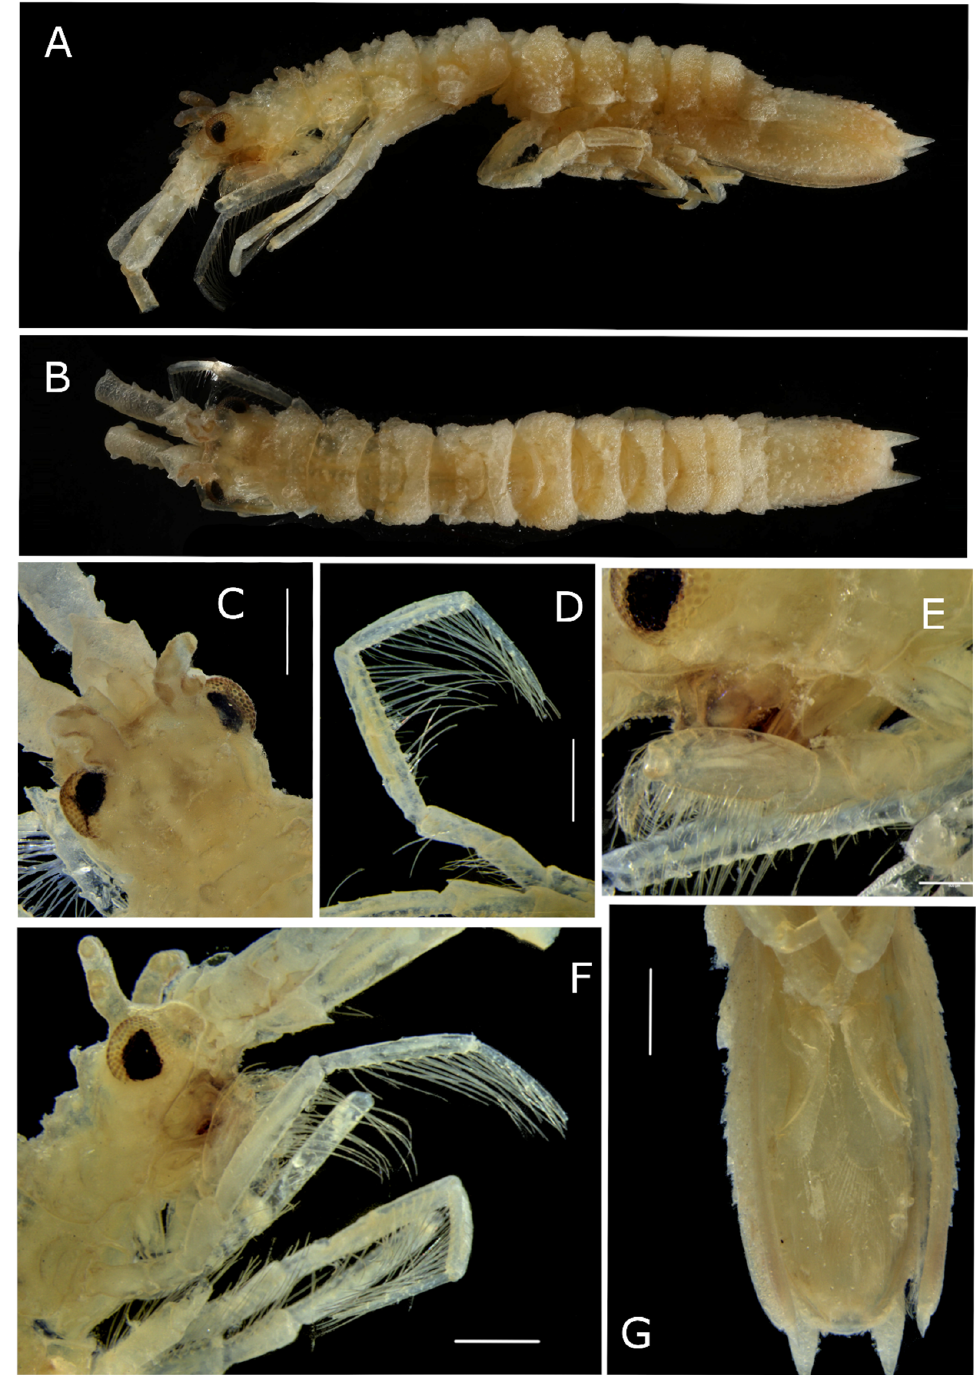
Figure 6. Chaetarcturus cervicornis sp. n., male holotype (MNA 10739) stack photos ( A ) lateral view ( B ) dorsal view ( C ) dorsal side of cephalothorax, where supraocular spines and the two pairs of blunt tubercle-like spines are evident ( D ) third pereopod ( E ) first pereopod ( F ) lateral side of cephalothorax, focus on second pereopod ( G ) ventral side of the pleotelson, focus on pleopods. Scale bar = 1 mm except in ( E ) where scale bar = 0.5 mm.